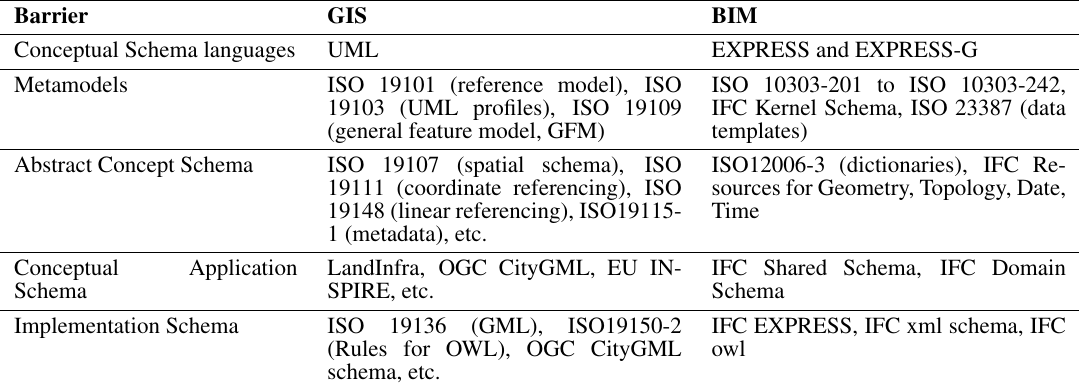
Table 1. Summary (and simplification) of the BIM/GIS comparison, structured according to model driven architecture (MDA). BIM